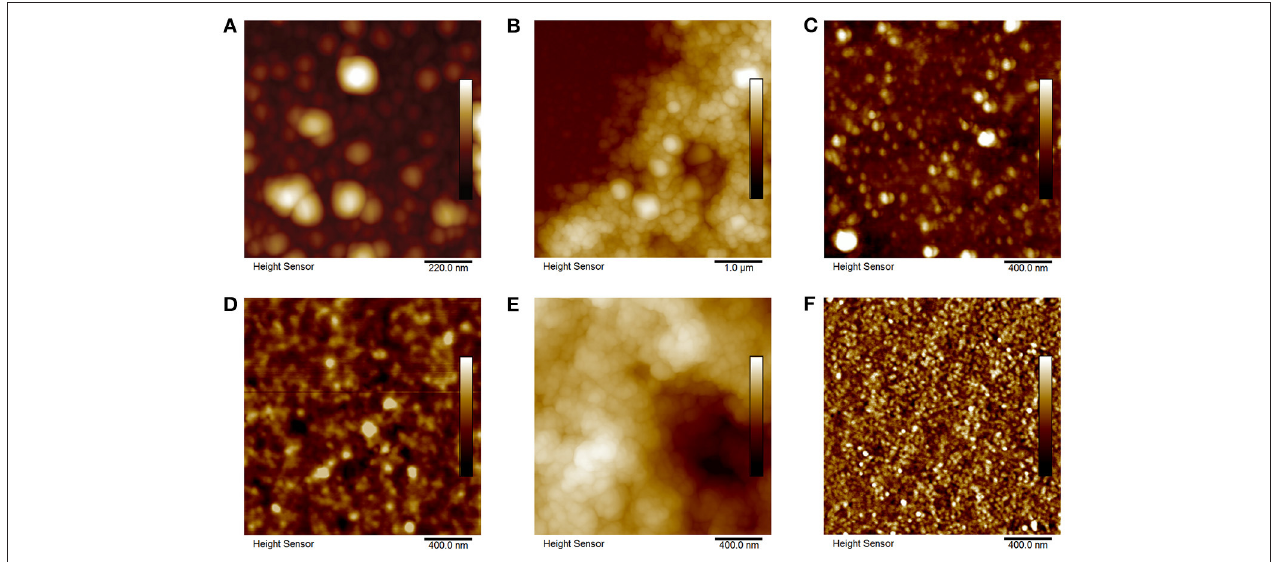
FIGURE 1 | Topography in air of coating formed by rSfp1 Beta C-term, rSfp1 Delta and Bovine Serum Albumin previously prepared in different buffers, rinsed in dionized water and air dried. (A) rSfp1 Beta C-term ASW (Scale: 50nm), (B) rSfp1 Beta C-term 450mM NaCl (scale: 600nm), (C) rSfp1 Delta ASW (Scale: 40nm), (D) rSfp1 Delta 150mM CaCl 2 (Scale: 15nm), (E) mix of rSfp1 Beta C-term and rSfp1 Delta ASW, (F) Bovine serum albumine ASW (Scale: 2.5nm).